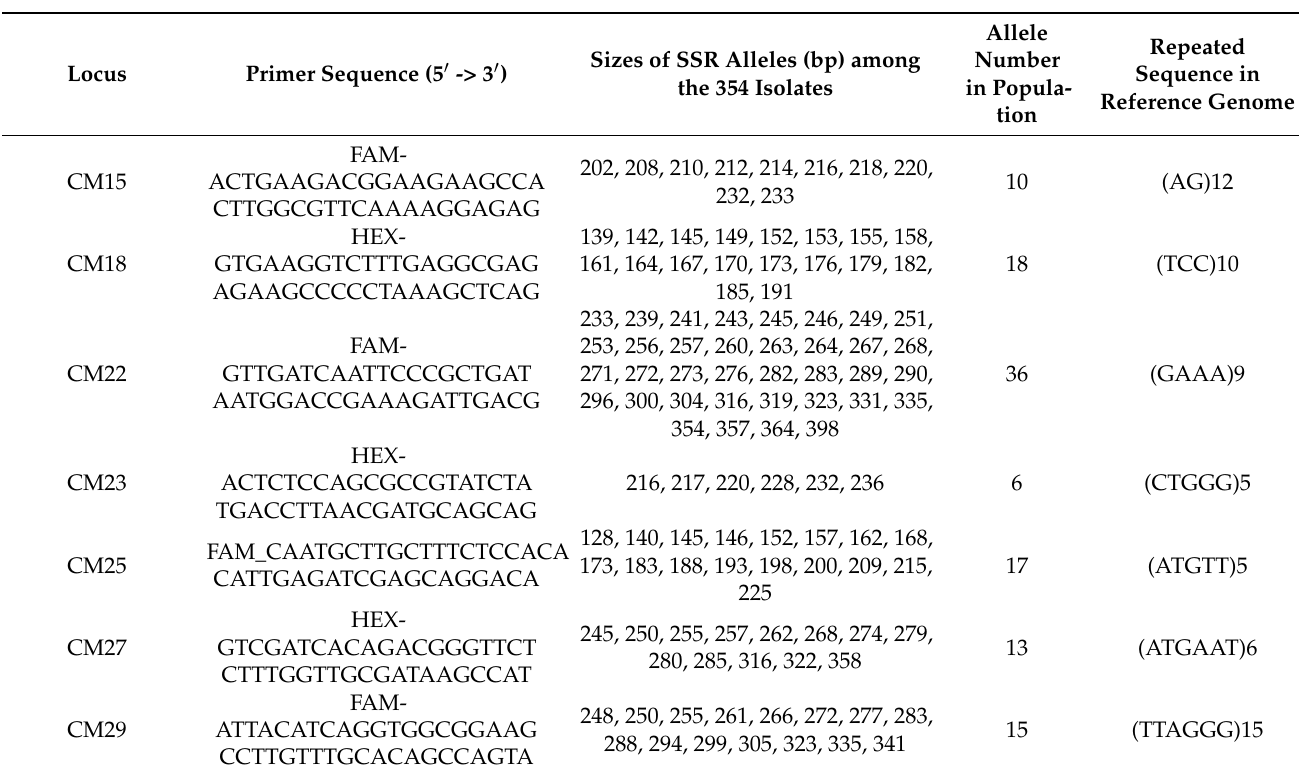
Table 2. Information about the seven SSR marker loci, including primer sequences, amplified fragment length variations, allele number, and type of repeat